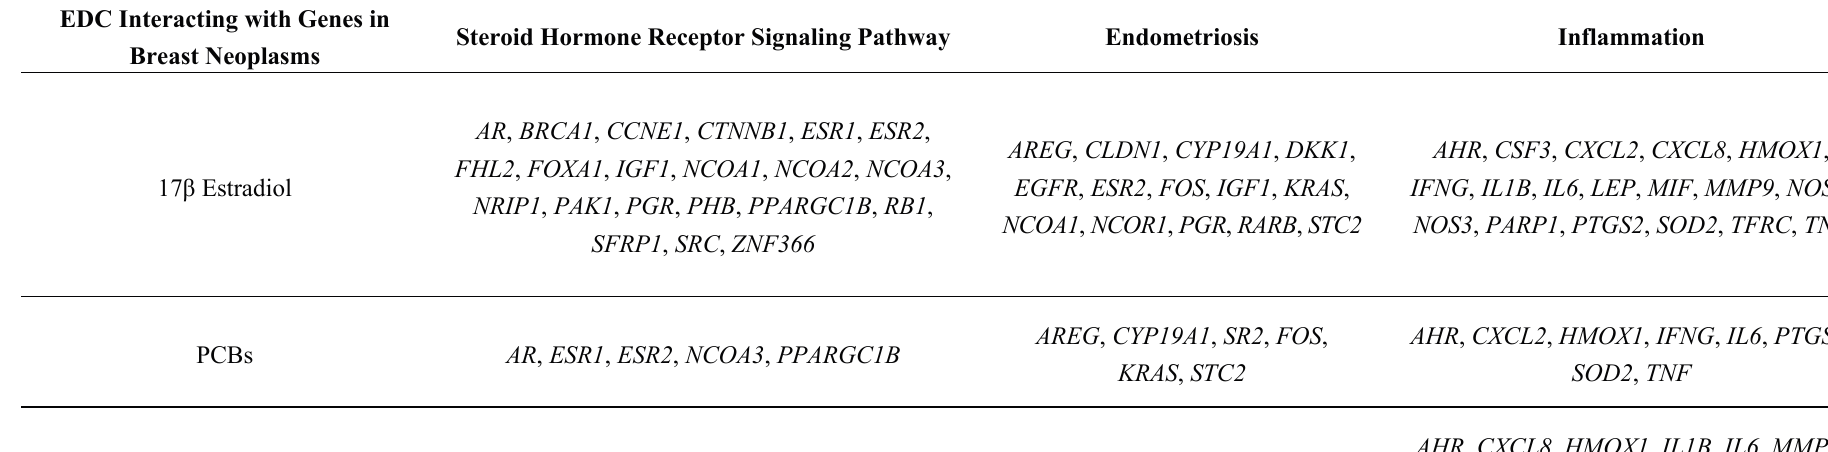
Table 7. EDCs observed in breast neoplasms that are associated with estrogen responsive gene interactions, endometriosis, and inflammation. EDC Interacting with Genes